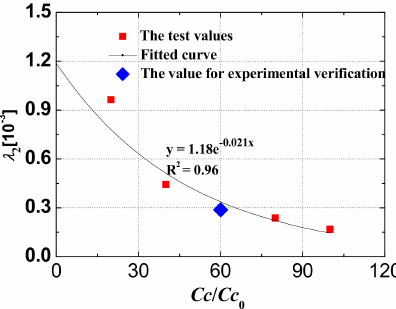
Figure 14. The relationship between the parameter λ 2 and cement content Cc .